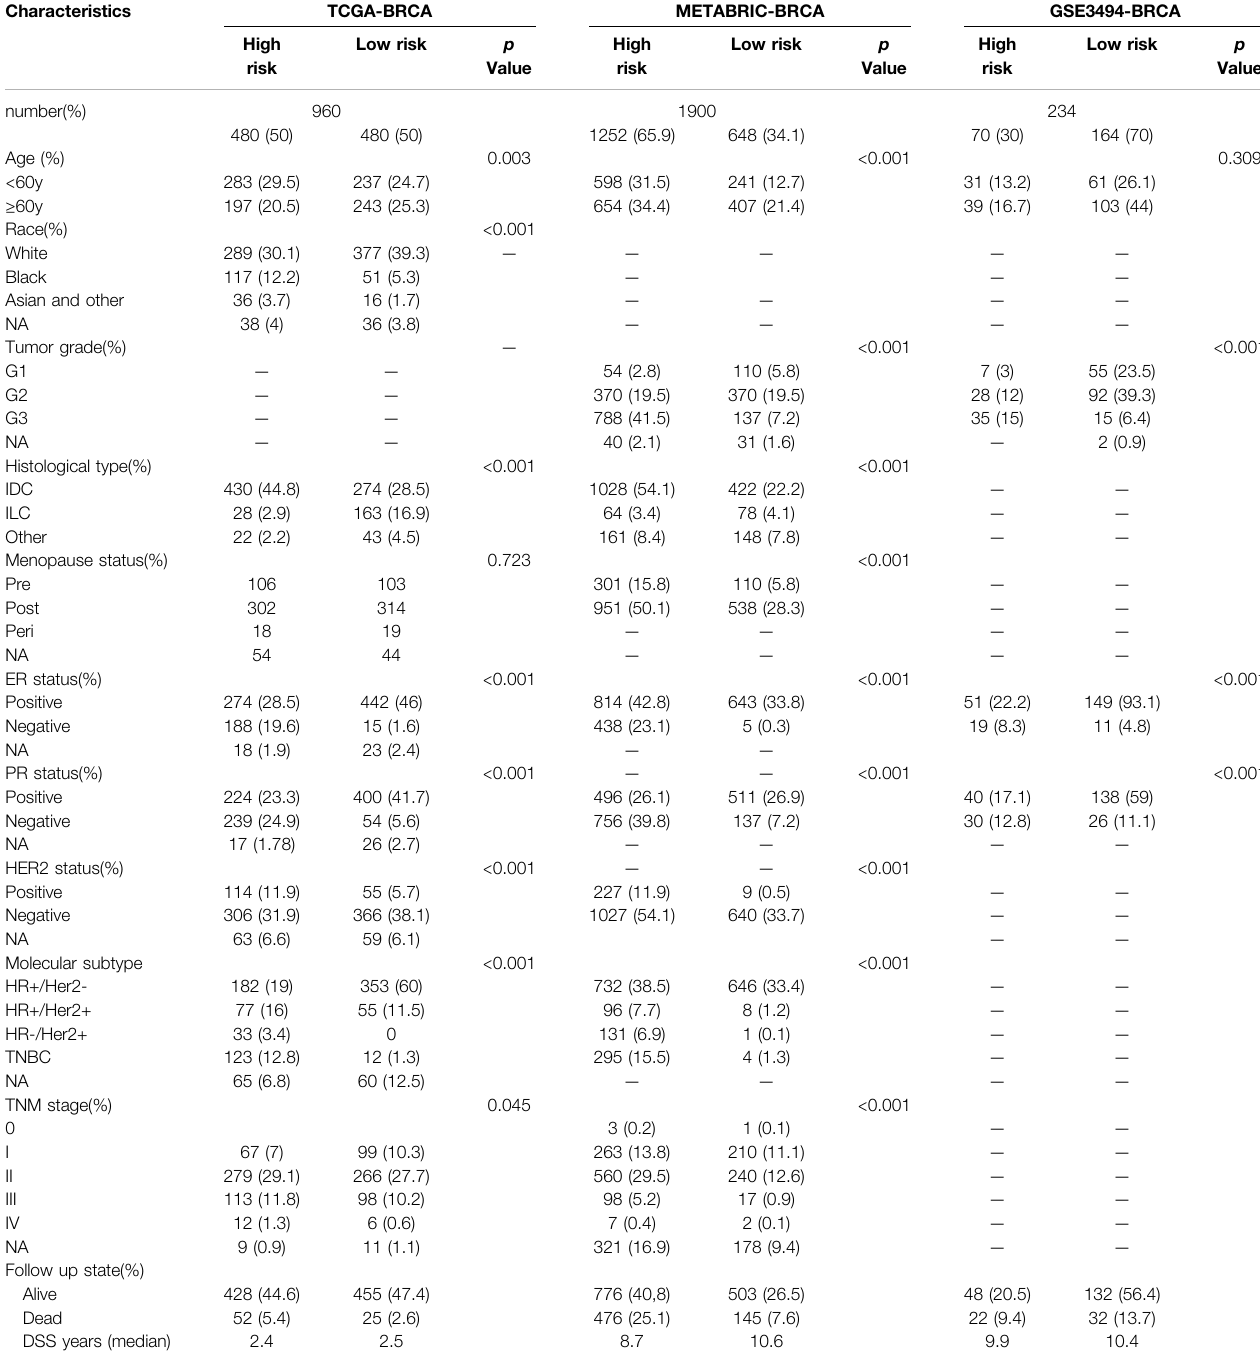
TABLE 2 | Clinical features in different risk subgroups.